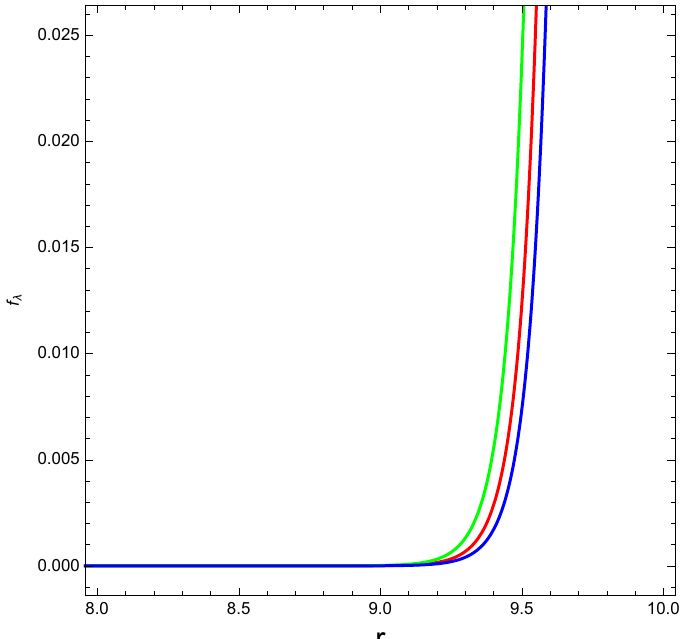
Figure 5. Solution of f ( R ( r )) for R adopted as a linear function of radius. The evolution of Equation (7) under f ( R ( r )) gravity is provided. We have fixed the values of η 2 , η 3 , a 0 , a 1 , a 2 , K , and C 1 . The red, green, and blue lines correspond to small perturbations of λ 0 , Ψ 0 , and η 1 , respectively.